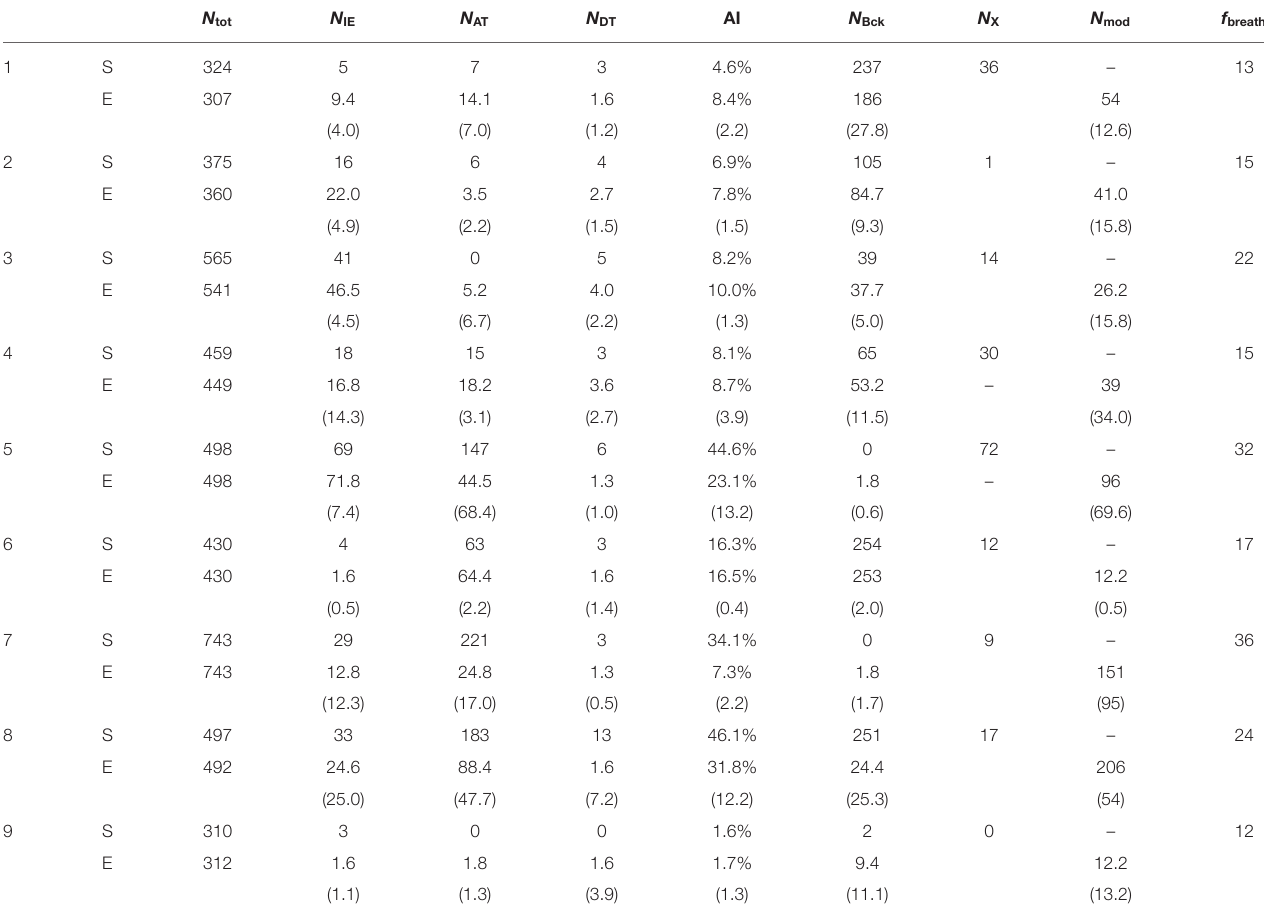
TABLE 2 | Distribution of asynchrony events (AEs) according to the automatic scoring by